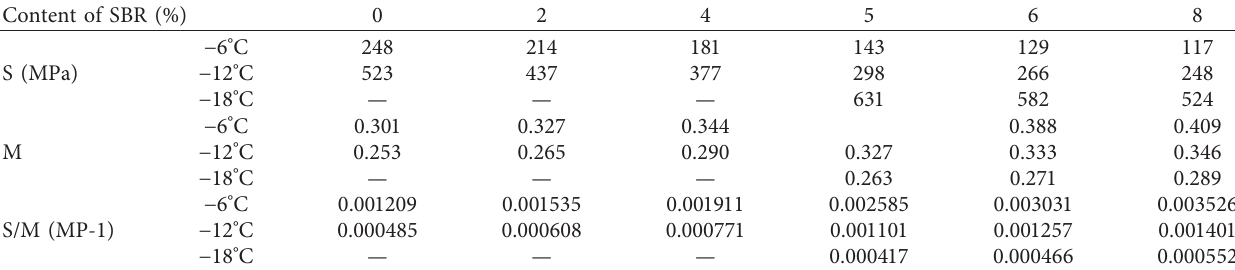
Table 7: BBR test results of BRA-SBR compound modified